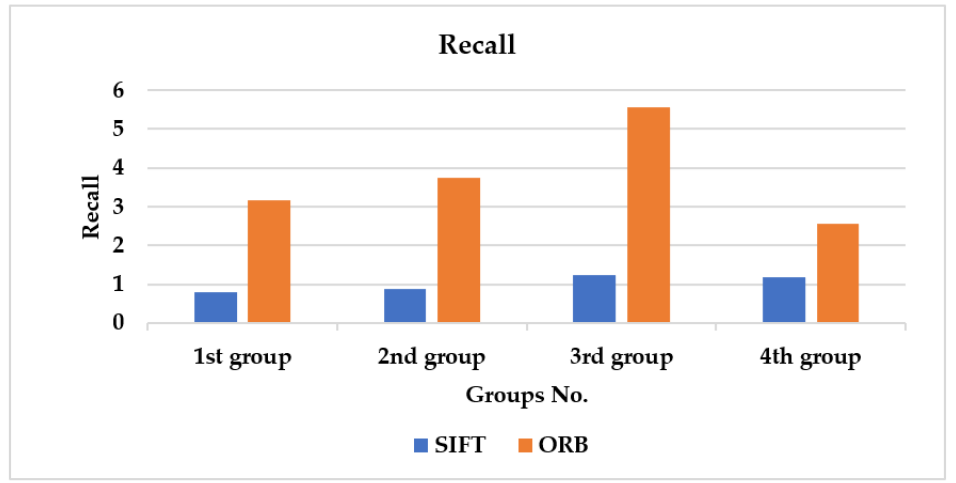
Figure 13. Average recall computed over the four groups created from ImageNet-Sketch dataset based on handcrafted features.